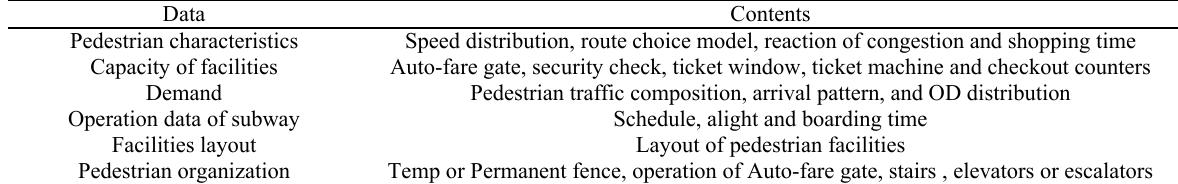
Table 2 Data preparation for pedestrian simulation